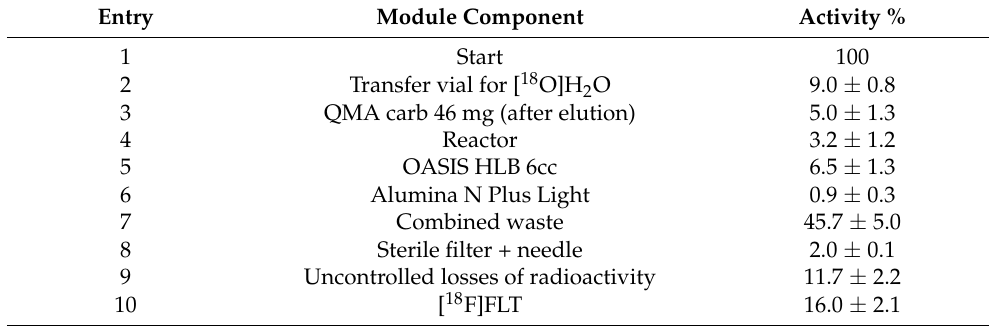
Table 2. Activity balance (data is decay corrected, recalculated to 100%; n = 5) after synthesis [ 18 F]FLT with purification on OASIS HLB 6cc + Alumina N Plus